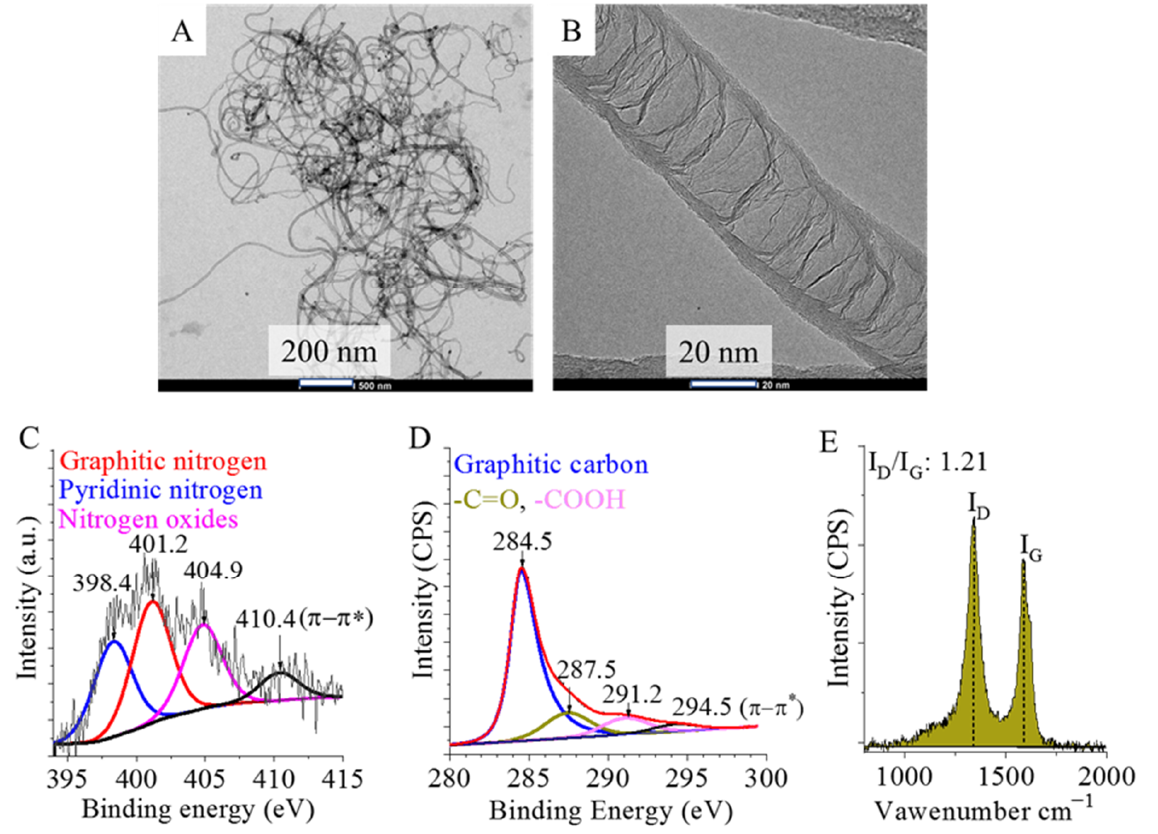
Figure 1. HRTEM images ( A , B ), deconvoluted N1s ( C ) and C1s band ( D ) on the XPS spectrum